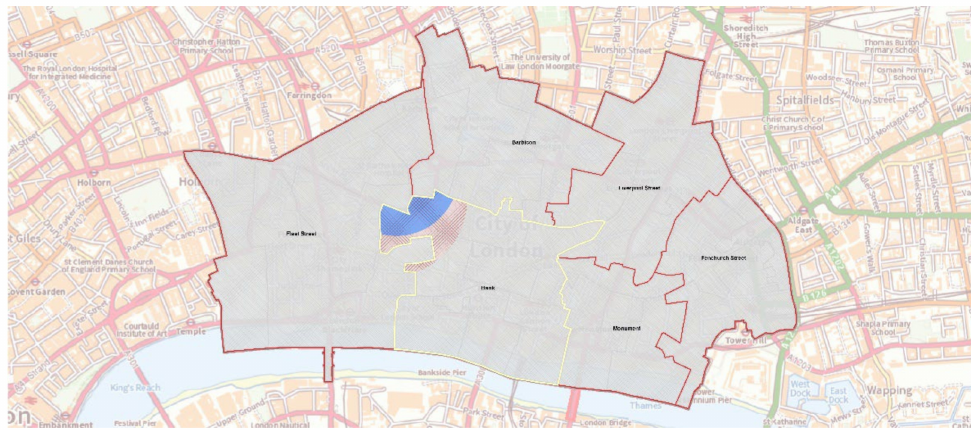
Figure 5. Drug crime hot spots in the Bank cluster for the years 2018 (marked in blue) and 2019 (marked in red).